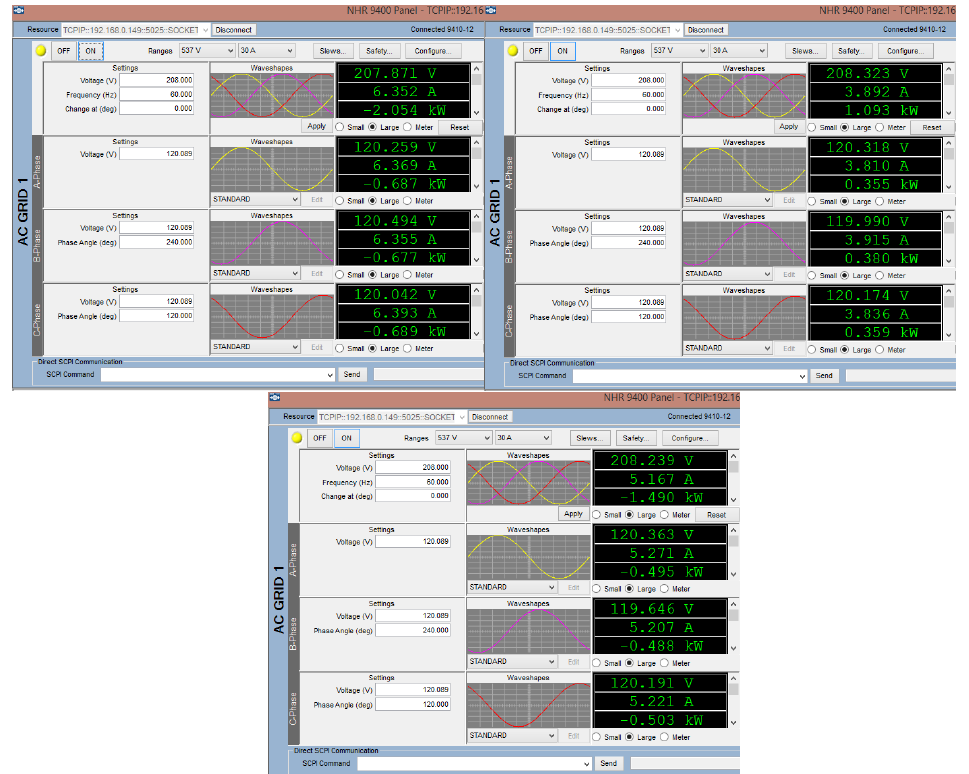
Figure 20. Experimental results using grid simulator NHR 9400